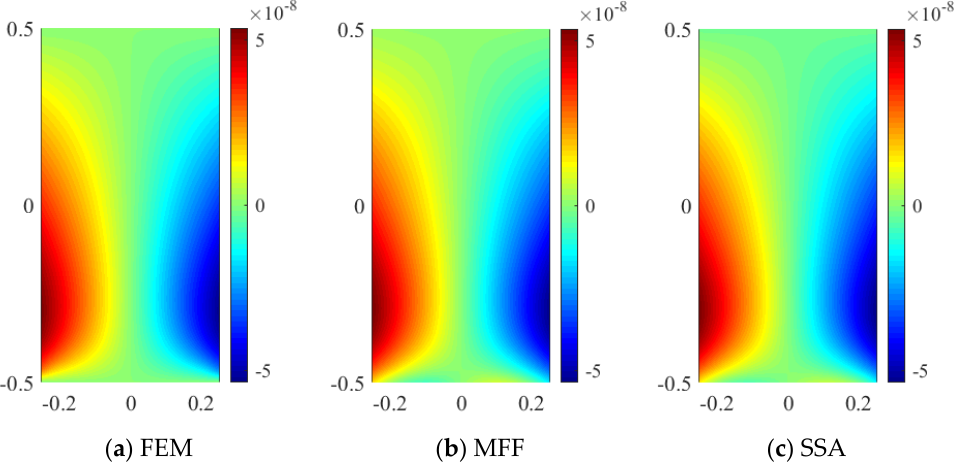
Figure 8. Displacements of u 1 calculated by the FEM and improved RBFCM.